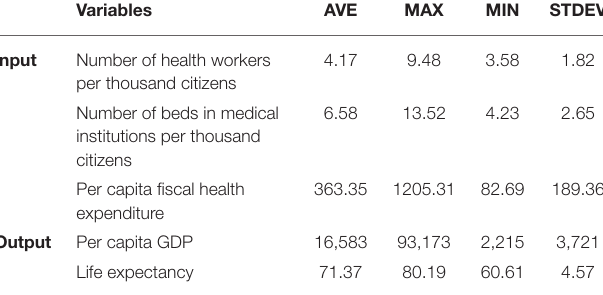
TABLE 2 | Descriptive